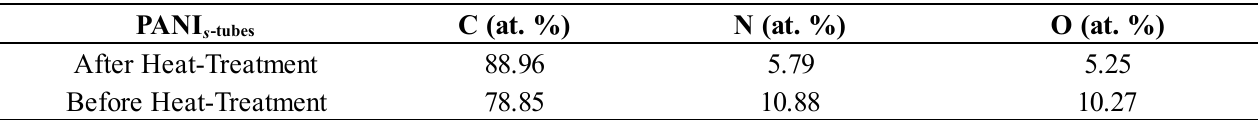
Table 1. The content values of C, N and O estimated from XPS results for PANI s -tubes before and after heat-treatment.